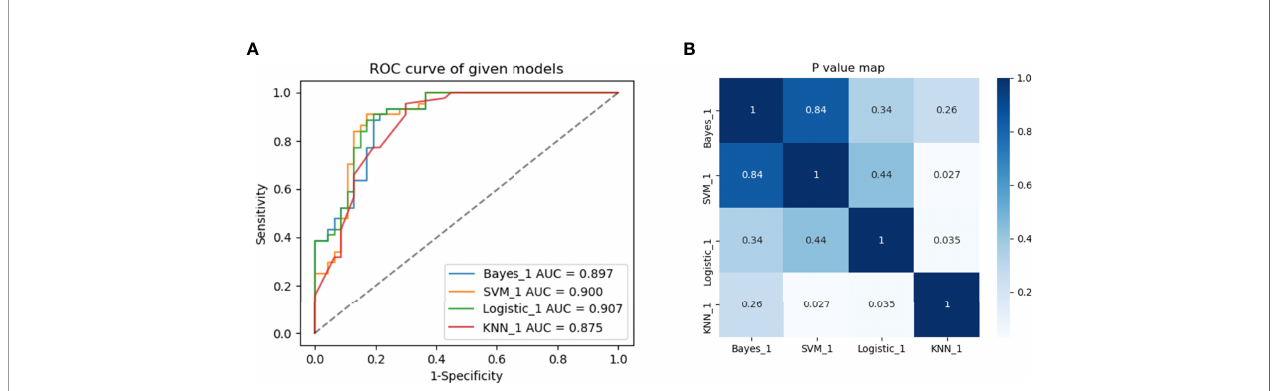
FIGURE 4 | Predictive performance of different machine learning methods. (A) Four machine learning methods and (B) heat maps comparing p -values of AUCs in the training set